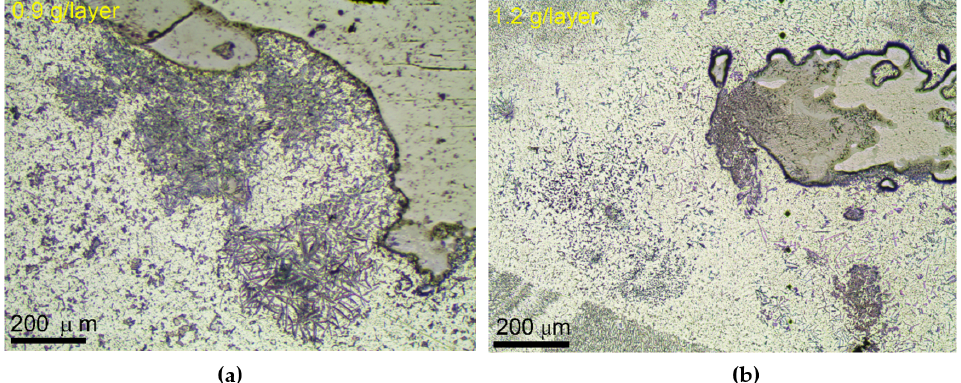
Figure 4. AA5154/Mo IMCs formed near the Mo-rich particles in 0.9 g/layer ( a ) and 1.2 g/layer ( b ) samples.